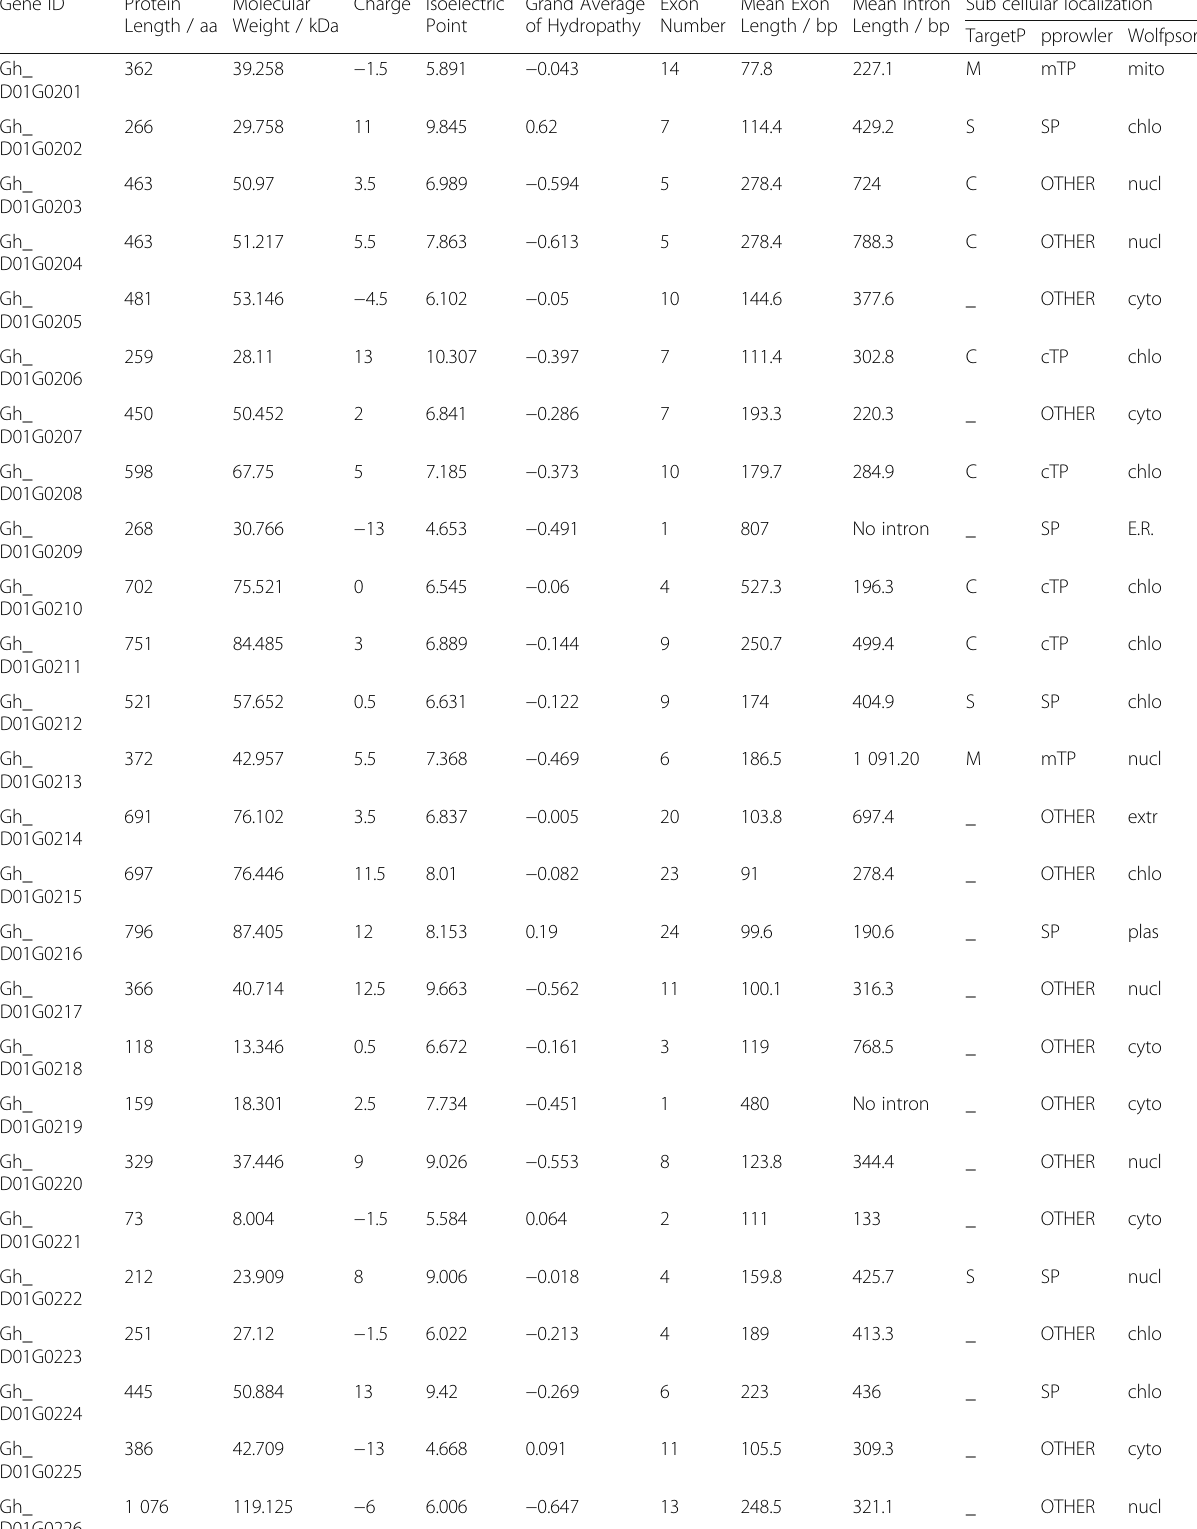
Table 3 Physiochemical properties and sub cellular localization prediction of the mined genes within the major clusters of the consistent QTLs (Continued) Gene